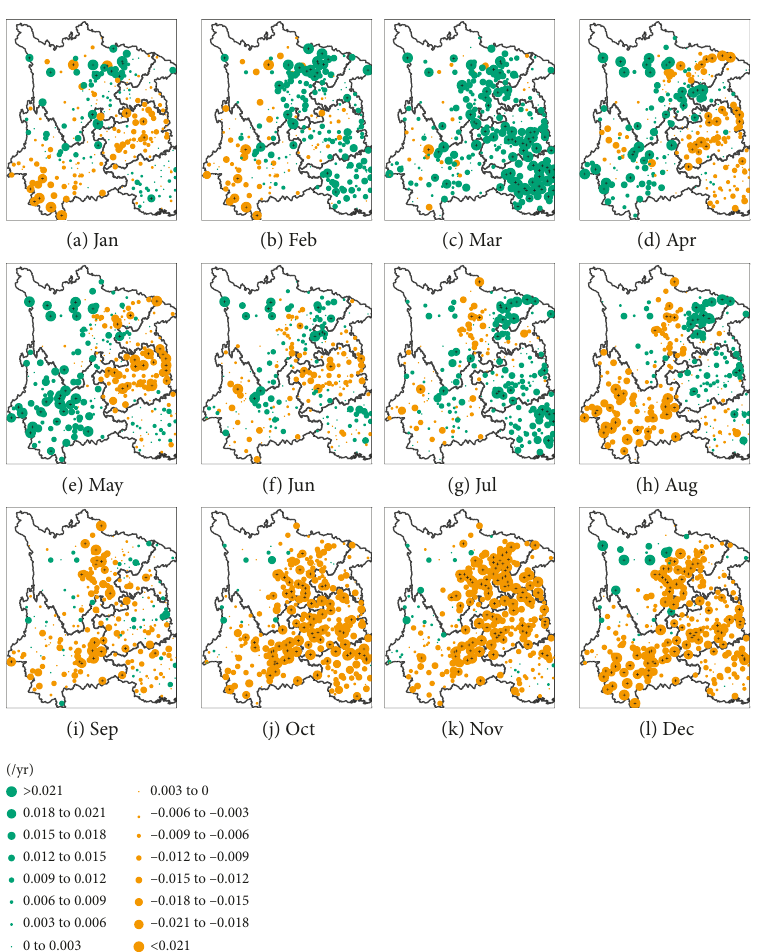
Figure 4: Spatial distributions of monthly ET 0 changes during 1961–2012. The plus sign denotes that trend is